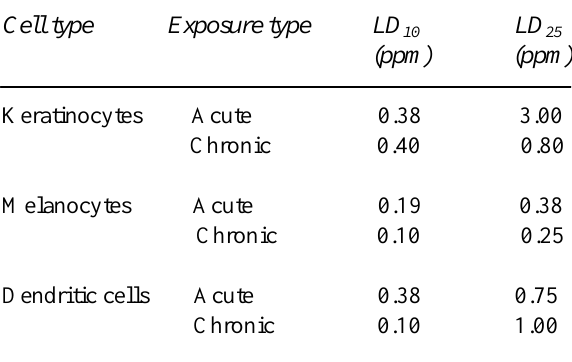
Table 1: Cytotoxicity (LD trioxide in acute and chronically-exposed skin